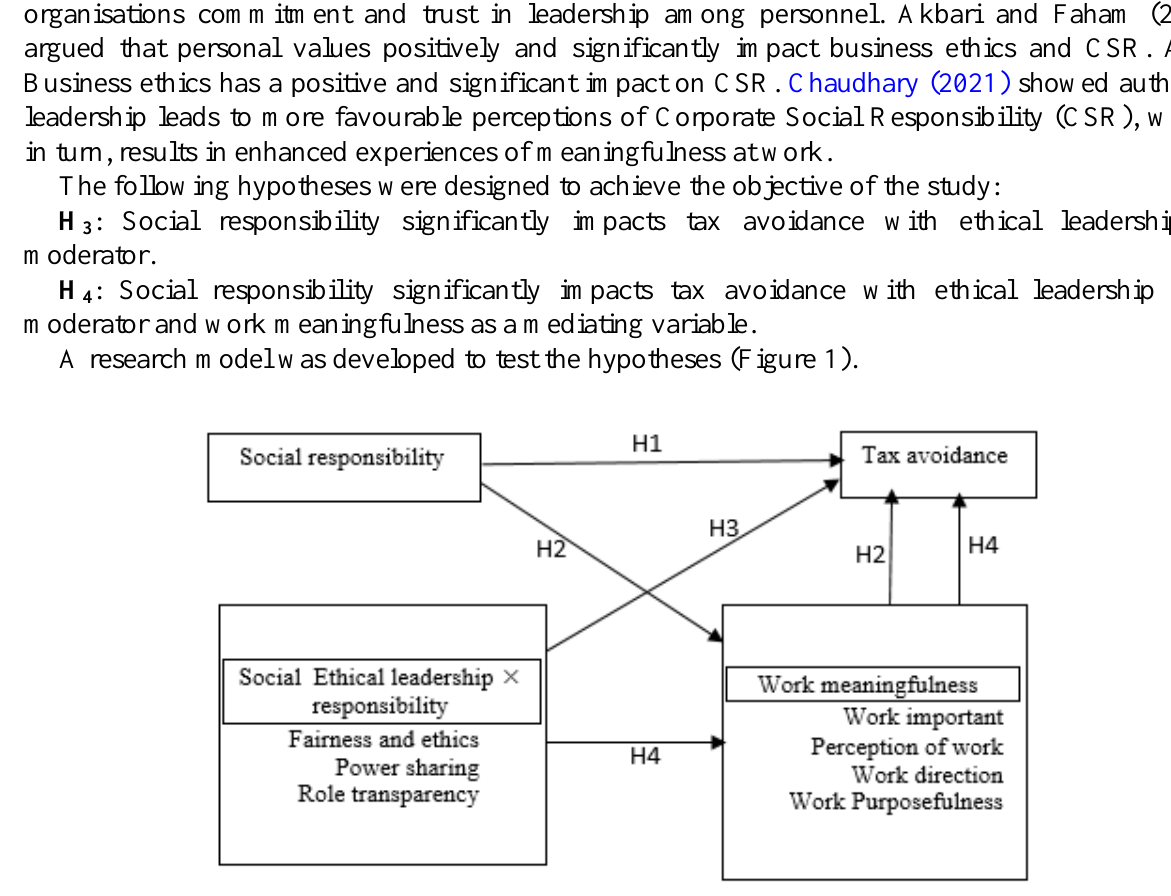
Figure 1. Research operational model (based on Akdoğan, Arslan and Demirtaş,